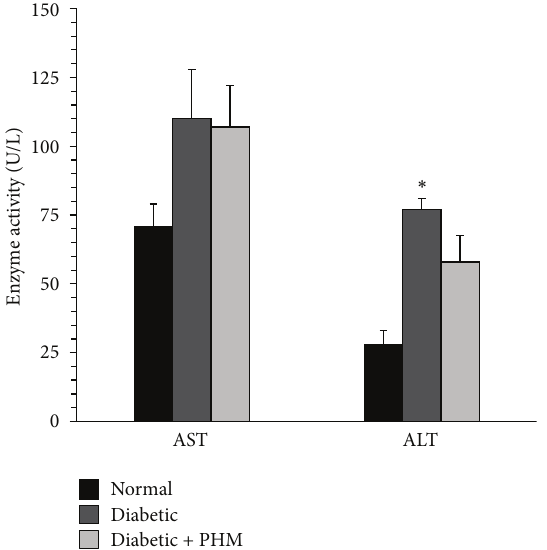
Figure 2: Effects of the polyherbal mixture (PHM) on the levels of plasma lipids. The animals in group of diabetic + PHM received PHM for 4 weeks. ∗ 𝑃 < 0.05 versus normal rats. ∗∗ 𝑃 < 0.01 versus normal rats. # 𝑃 < 0.05 versus diabetic control. The data are expressed as mean ± SEM for eight (diabetic + PHM) or six (normal and diabetic control) rats.